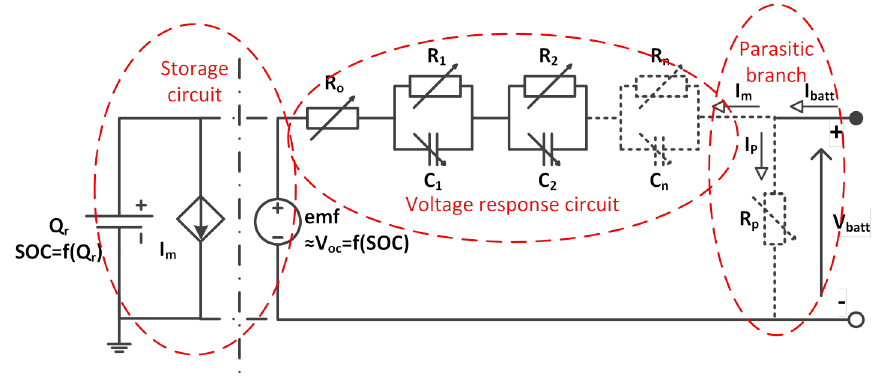
Figure 1. Schematic of the overall EECM